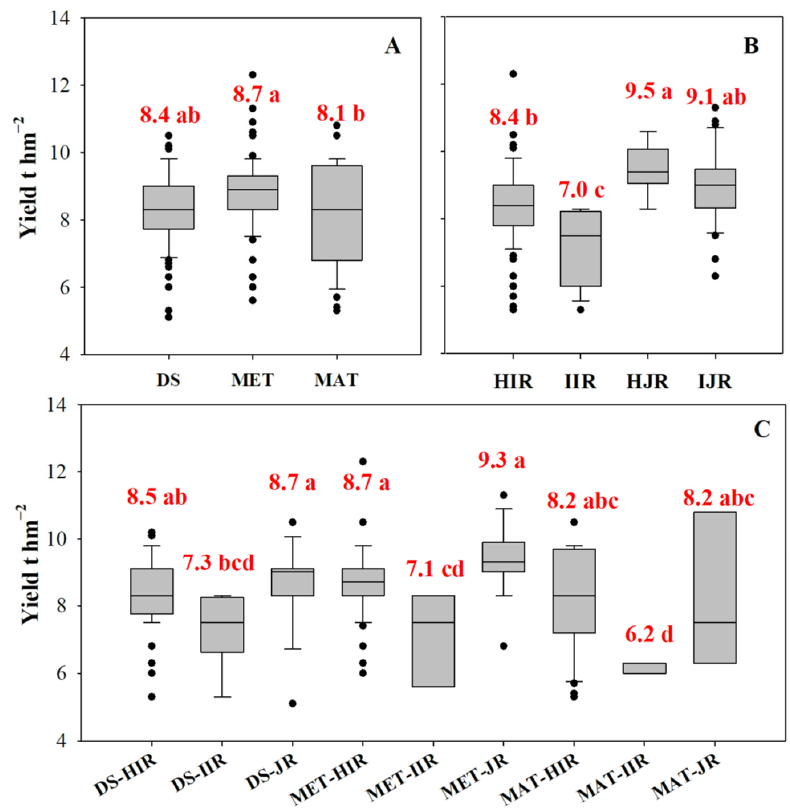
Figure 2. Differences in rice grain yield across different establishment methods ( A ), different types of rice ( B ), and their interactions ( C ). DS, MET, and MAT represent directed seeded method, mechanical transplanted method, and manual transplanted method, respectively. HIR, IIR, HJR, and IJR represent hybrid indica rice, inbred indica rice, hybrid japonica rice, and inbred japonica rice, respectively. JR represents japonica rice (including hybrid japonica rice and inbred japonica rice). The red data is the average grain yield of each series. The same letter are not significantly different at p = 0.05. Data were pooled from examinations conducted in 2020.